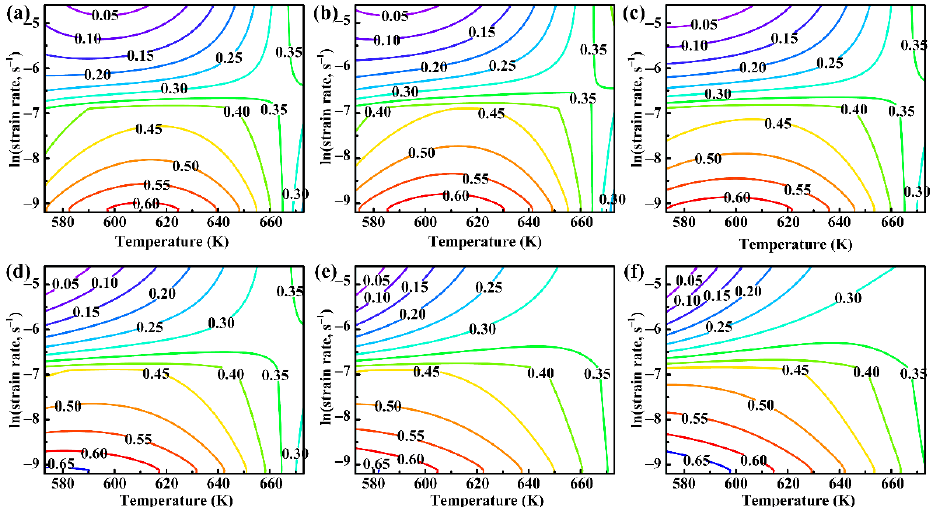
Figure 8. The power dissipation maps of as-extruded Mg–6Zn–5Ca–3Ce fabricated by RS at various strains: ( a ) 0.1; ( b ) 0.2; ( c ) 0.3; ( d ) 0.4; ( e ) 0.5; ( f ) 0.6.